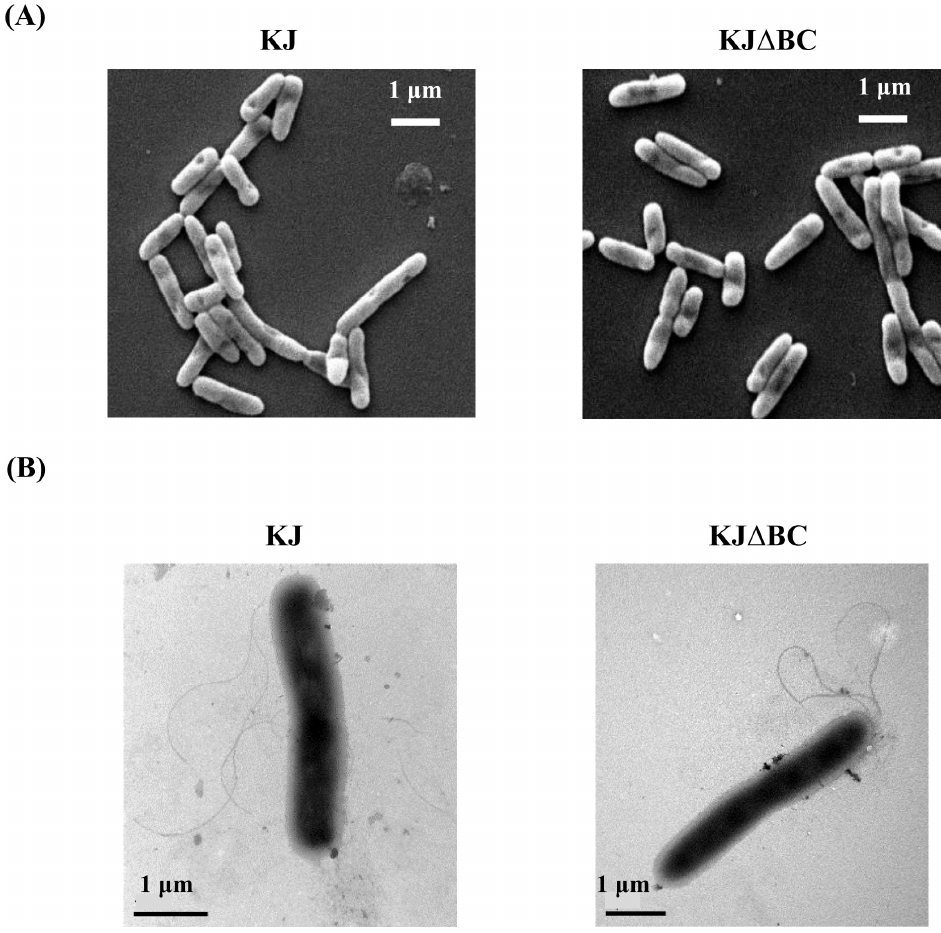
Fig 1. Role of CreBC TCS in bacterial and flagella morphologies. The overnight-cultured bacteriawere adjustedto an initial OD 450 of 0.15. After a 5-h incubationat 37˚C, the logarithmic-phase cells were harvested for morphology observation. (A) Bacterial morphology. The samples for bacterial morphologyobservation were processedby glutaraldehyde-osmiumtetraoxide (OsO 4 )-ethanolmethod and examinedsuing SEM. (B) Flagellamorphology. The flagellawere negatively strainedwith 1% phosphotungstic acid (pH 7.4) and observedby TEM.